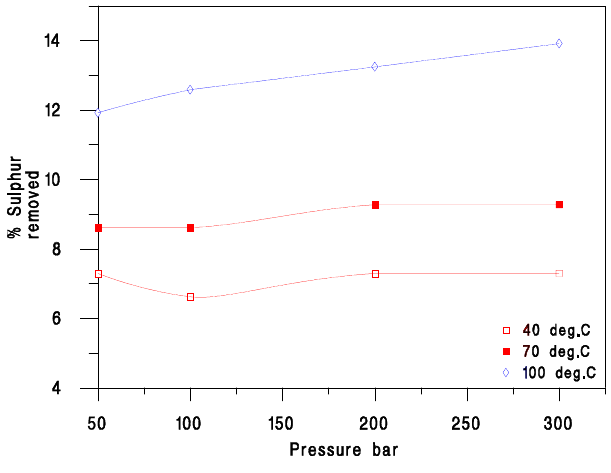
Figure 7. Effect of air pressure on organic sulphur removal for Harworth